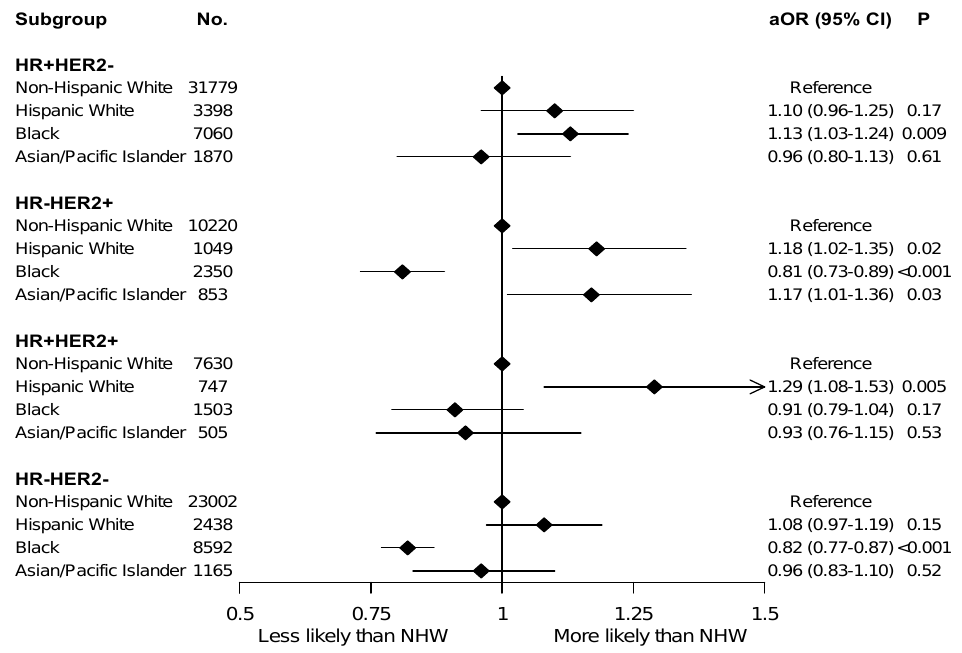
Figure 1. Trends in proportion of pathologic complete response from 2010 to 2017 for all cohorts. Error bar represents 95% confidence interval.